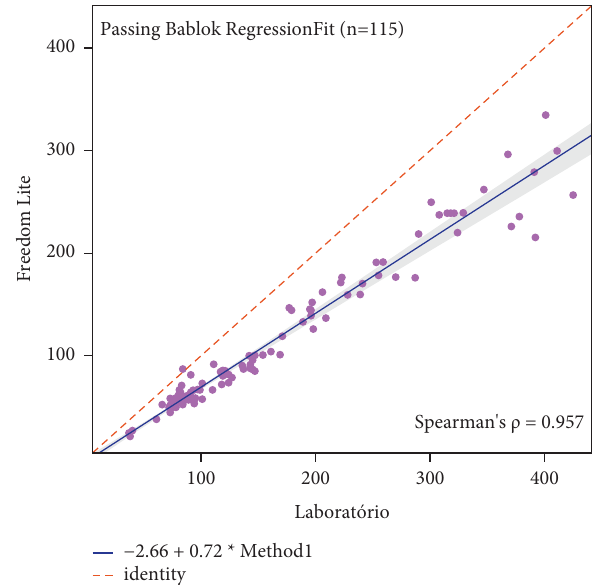
Figure 3: Passing-Bablok regression for the FreeStyle Freedom Lite ® glucometer.